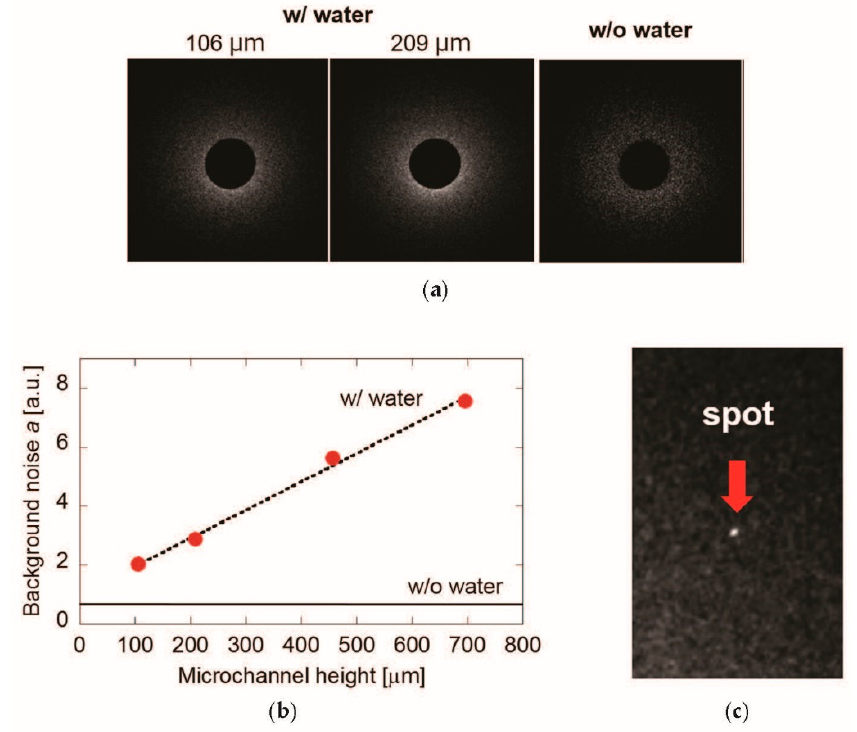
Figure 4. ( a ) Example images of the recorded background noise; ( b ) Noise level dependence on thickness for different height of the microchannel evaluated by the average of 100 images captured; ( c ) Close-up view of the captured the diffraction spot from a gold nanocrystal with the 50 μ m-height